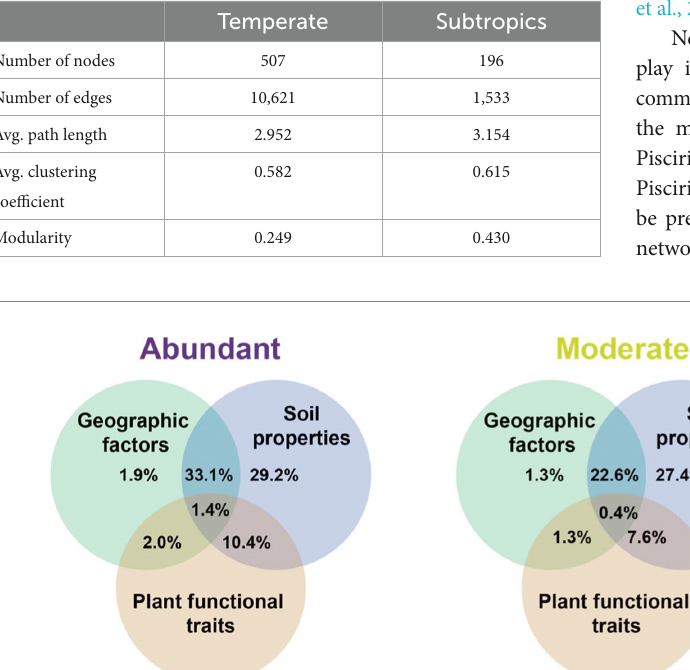
TABLE 3 Topological properties of the ecological networks in comparison to random networks.